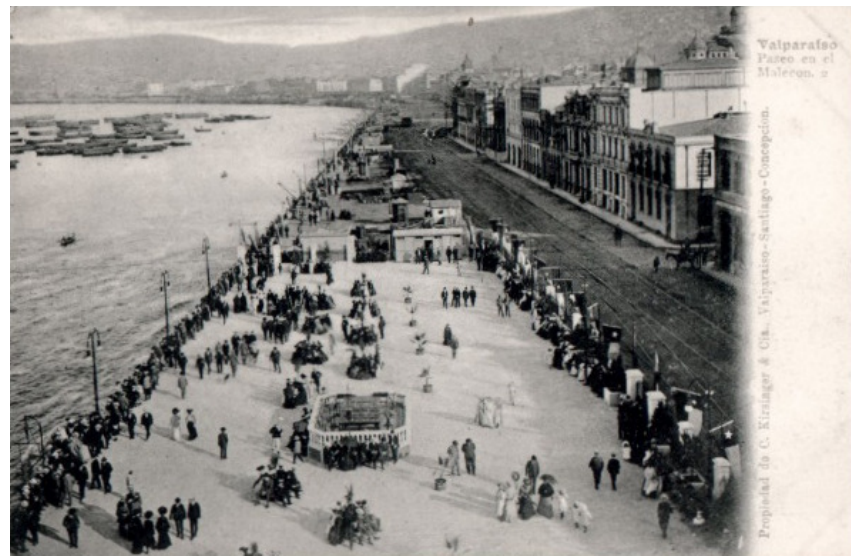
Figure 2. Valparaíso: Paseo en el Malecón, 2 [Valparaíso: Promenade on the Waterfront, 2]. Carlos Kirsinger and Cía. Source: Chilecollector